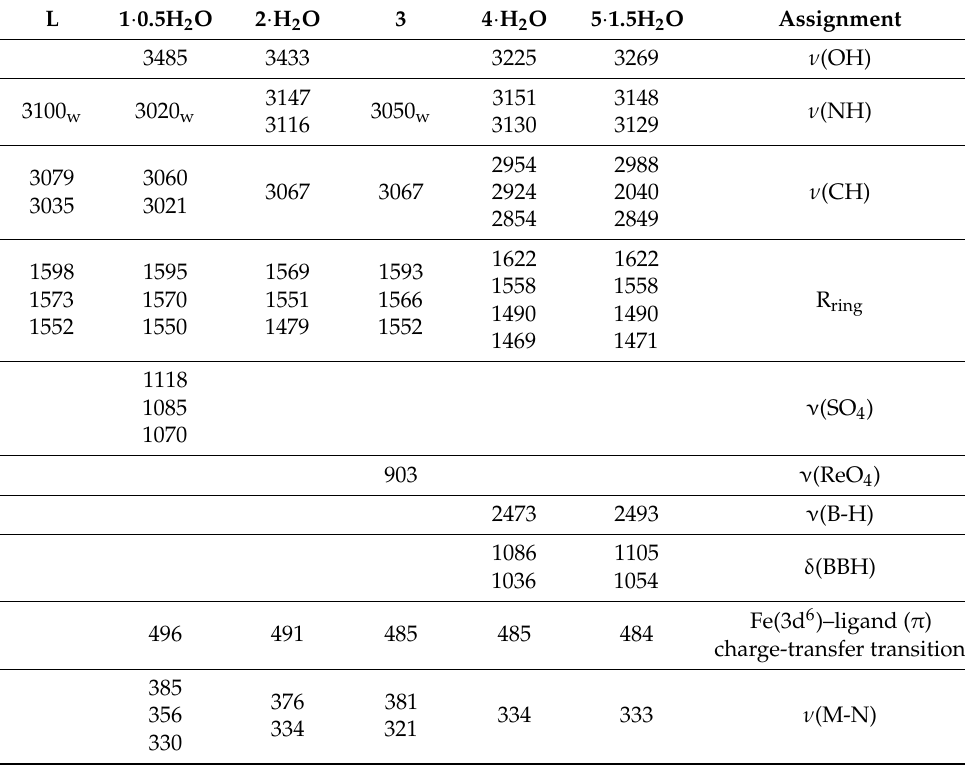
values C and ∆ LS (Table 4) were calculated using the equations: ν LS = ∆ LS − C + 86B 2 / ∆ LS and C = 4.41 · B [36–38]. The obtained data show that 2,6-bis(1 H -imidazol-2-yl)pyridine is a strong field ligand. In addition, these data, as well as the values obtained for a number of previously synthesized Fe(II) complexes with 2,6-bis(benzimidazol-2-yl)pyridine and